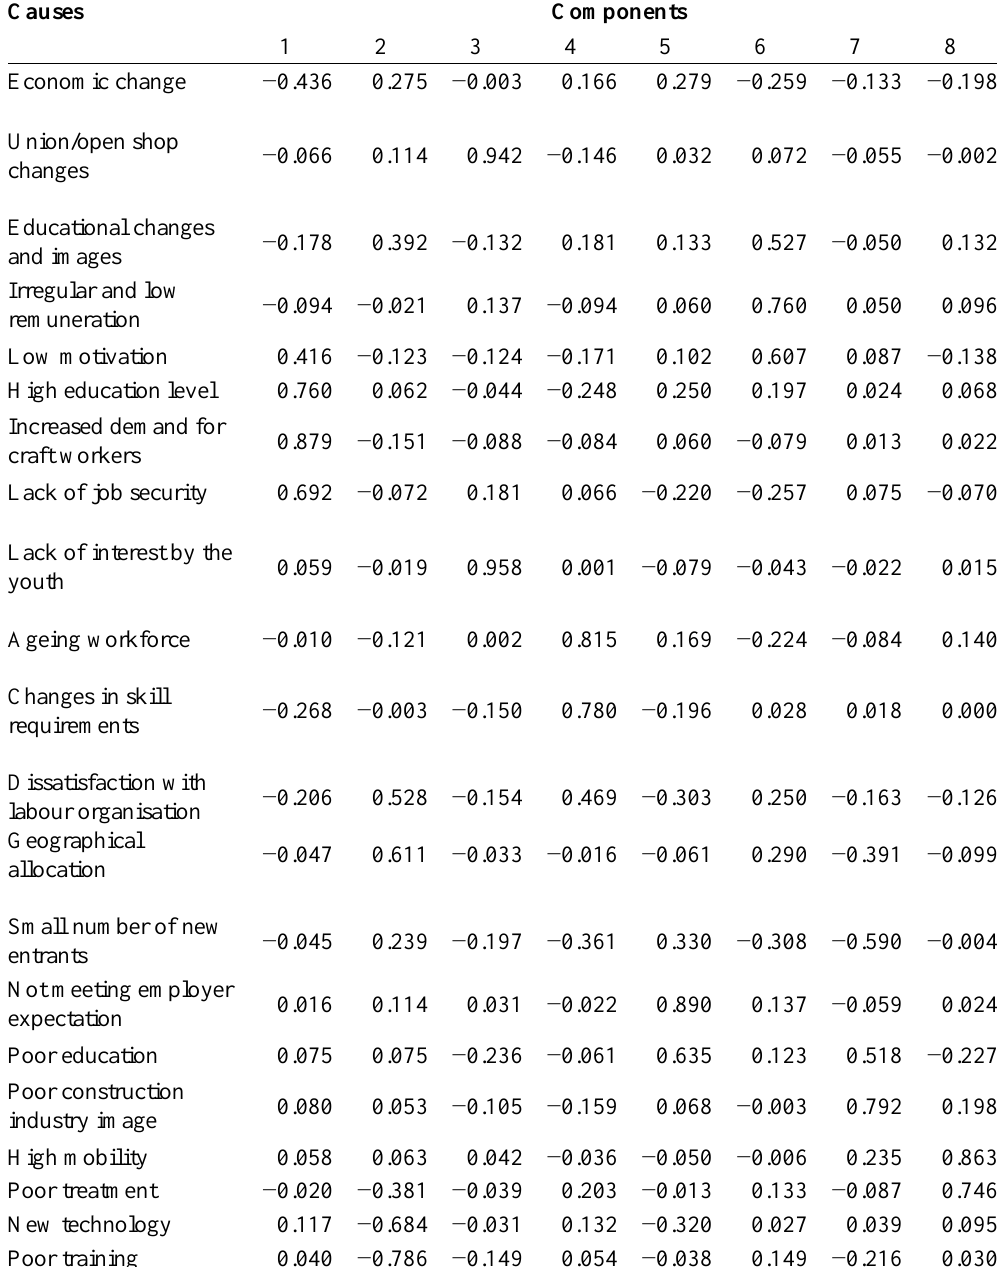
Table 4. Rotated Component